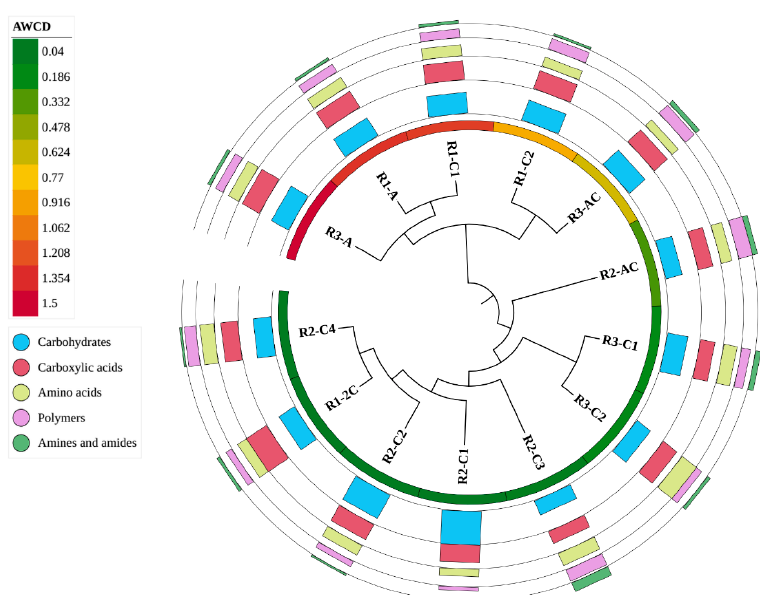
Figure 4. Phenotyping analysis based on results of Biolog ® EcoPlates™ analysis. Clustering analysis tree created on the basis of the results of the utilization of all substrates after the correction with negative control (UPGMA, Euclidean similarity index). Inner circle (color gradient) presents AWCD – average well colour developed. Multivalue bar charts present % utilization of different groups of substrates (each line presents a different group of substrates, as shown in the legend).